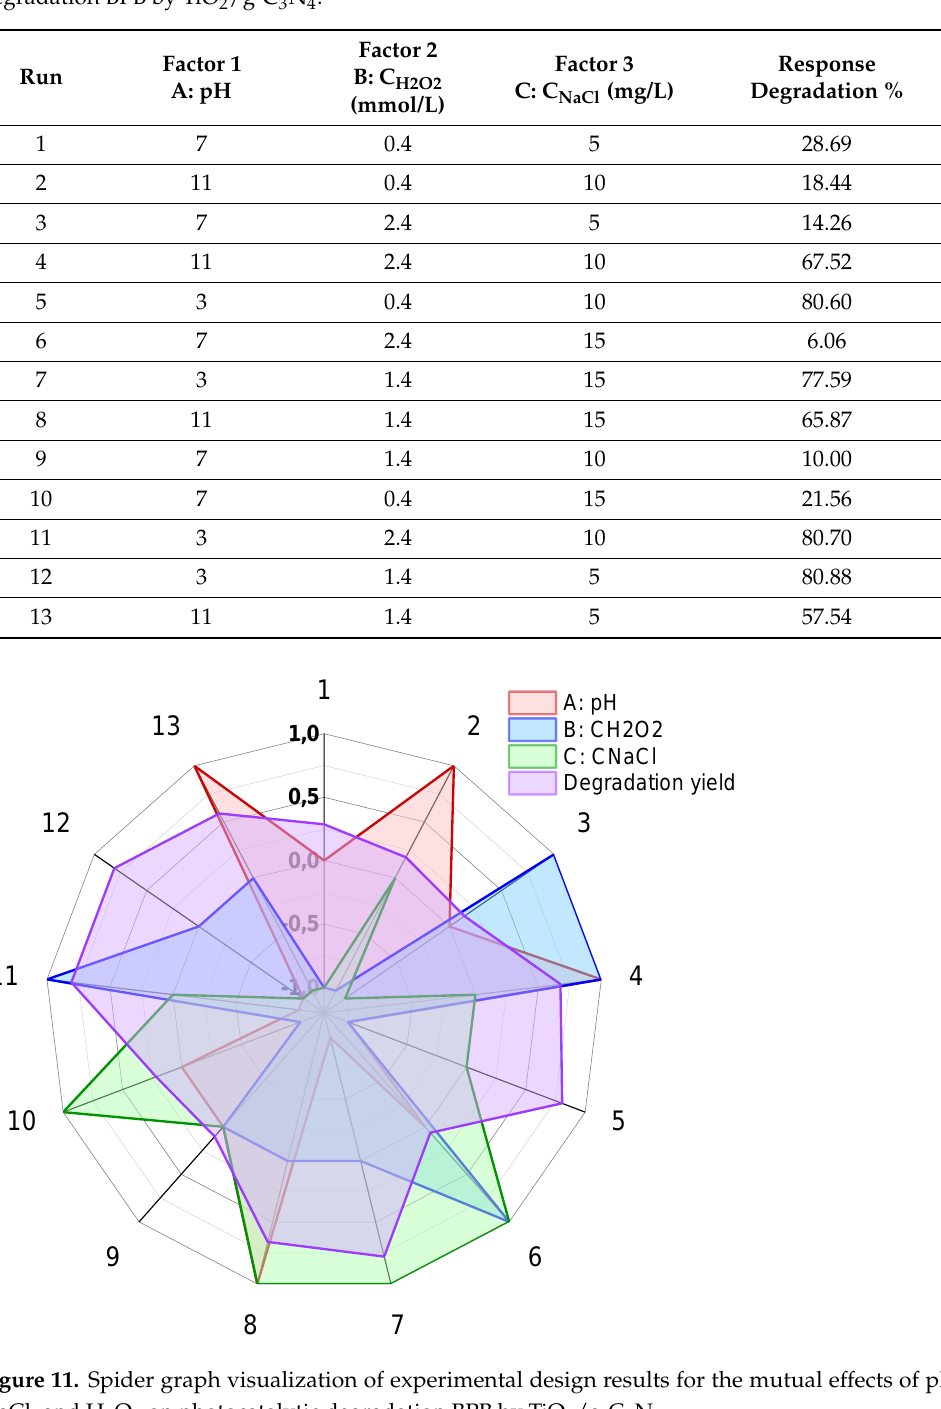
Table 4. Experimental design for the mutual effects of pH, NaCl, and H 2 O 2 on photocatalytic degradation BPB by TiO 2 /g-C 3 N 4 .